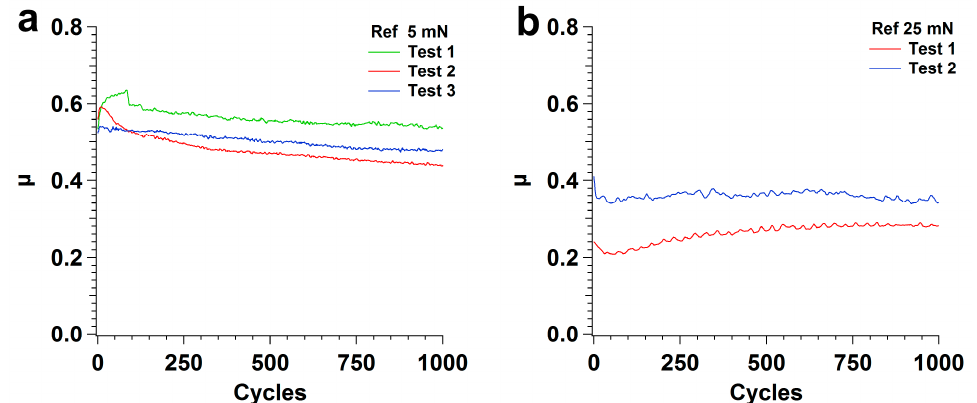
Figure 2. Variation of the friction coefficient with the number of cycles (proportional to the sliding distance) of consecutive tests for the polished Si specimen (Ref = Reference sample) at ( a ) 5 mN and ( b ) 25 mN.